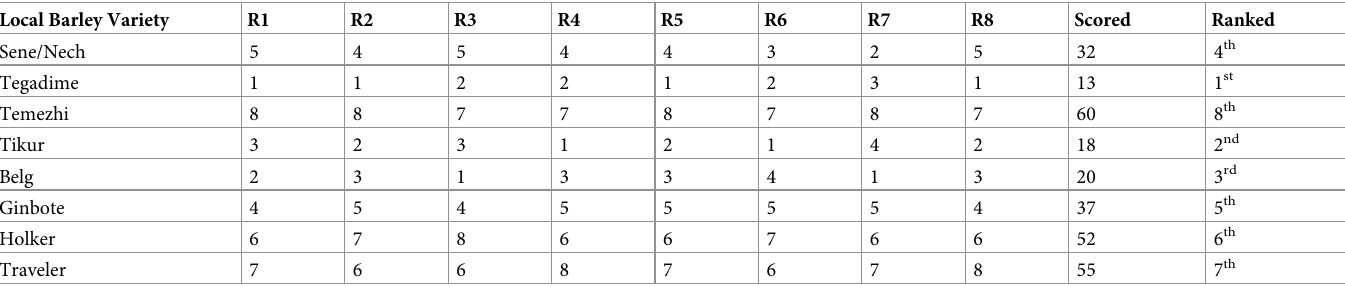
Table 1. Respondent’s preferences of barley landraces and varieties based on productivity. Local Barley